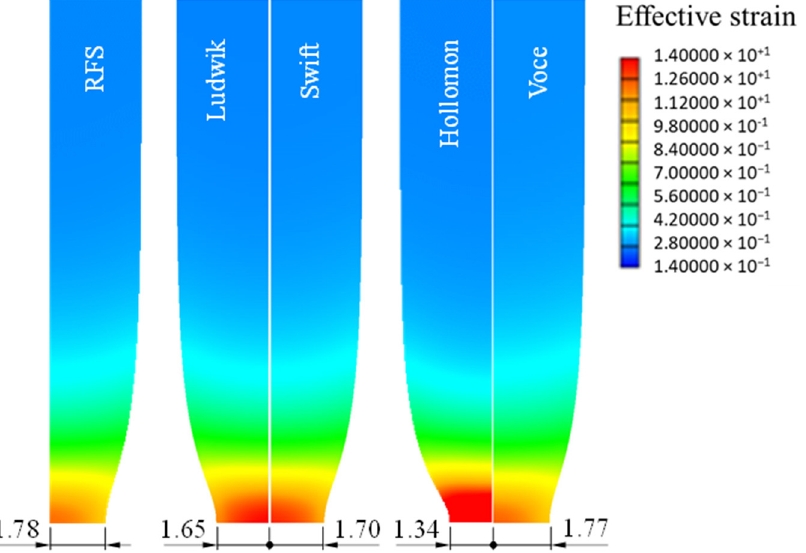
Figure 17. Comparison of deformed shapes of the tensile test, predicted using the RFS and funda- mental flow models.